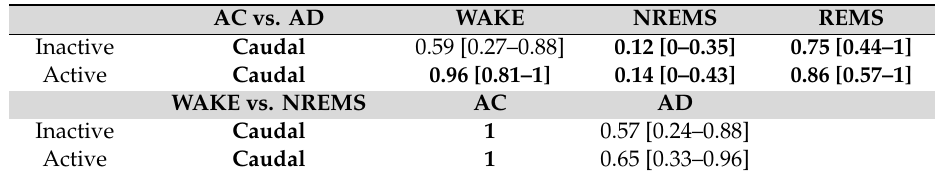
Table 1. Results of the AUC analysis to determine di ff erences in the EoD ( τ = 1) between the AC group and the AD group at certain vigilance states, as well as between WAKE and NREM sleep (NREMS) in either the AC or AD animals. Bold values indicate significance.